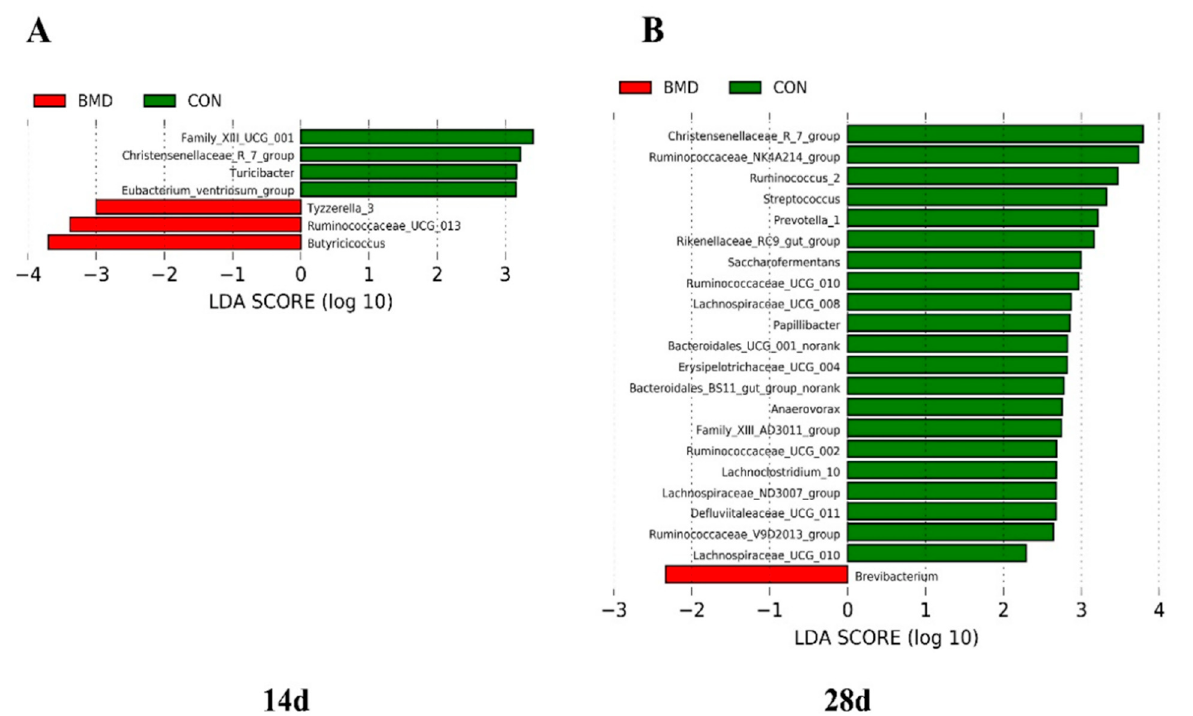
Figure 5. On Days 14 ( A ) and 28 ( B ) are plotted. At different growth stages, the BMD group and the CON group had different abundances of bacteria. Histograms of linear discriminant analysis (LDA) scores (threshold ≥ 2).